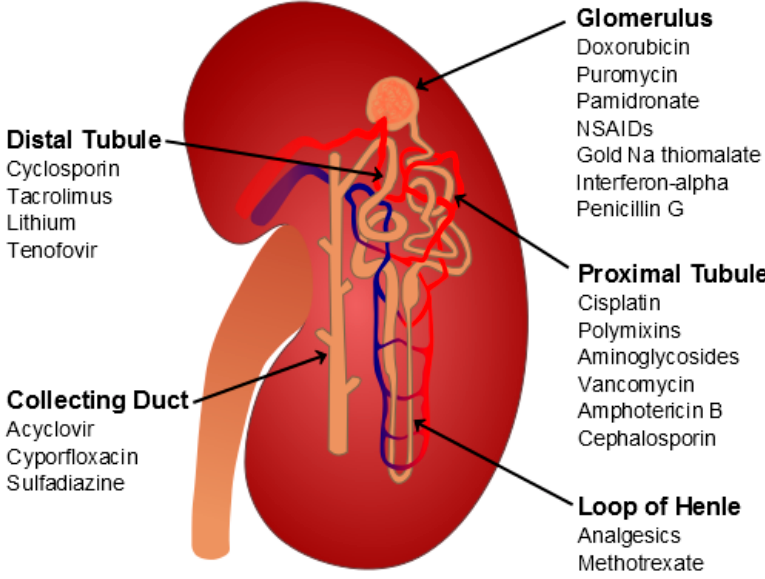
Figure 2. Main sites of drug-induced kidney injury. Schematic representation of a nephron, the functional unit of the kidney. Each nephron is composed of a glomerulus and a tubule. The glomerulus filters the blood, producing an ultrafiltrate mainly composed by small molecules, from nutrients to ions. The ultrafiltrate enters the tubule in which at various segments (proximal tubule, Henle’s loop and distal tubule) it is modified to obtain the final urine in the collecting duct.